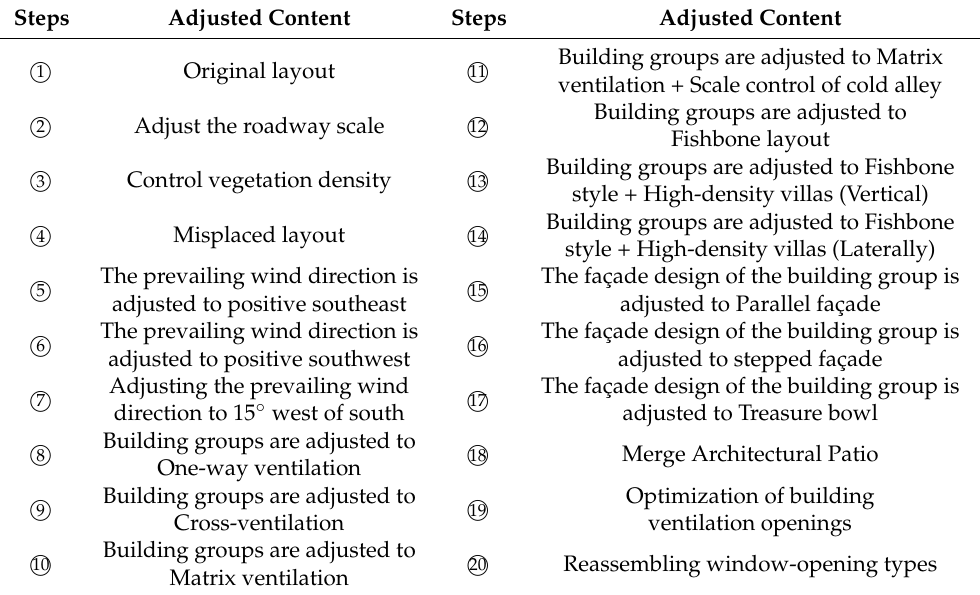
Table 11. The Coding table for improvement steps.